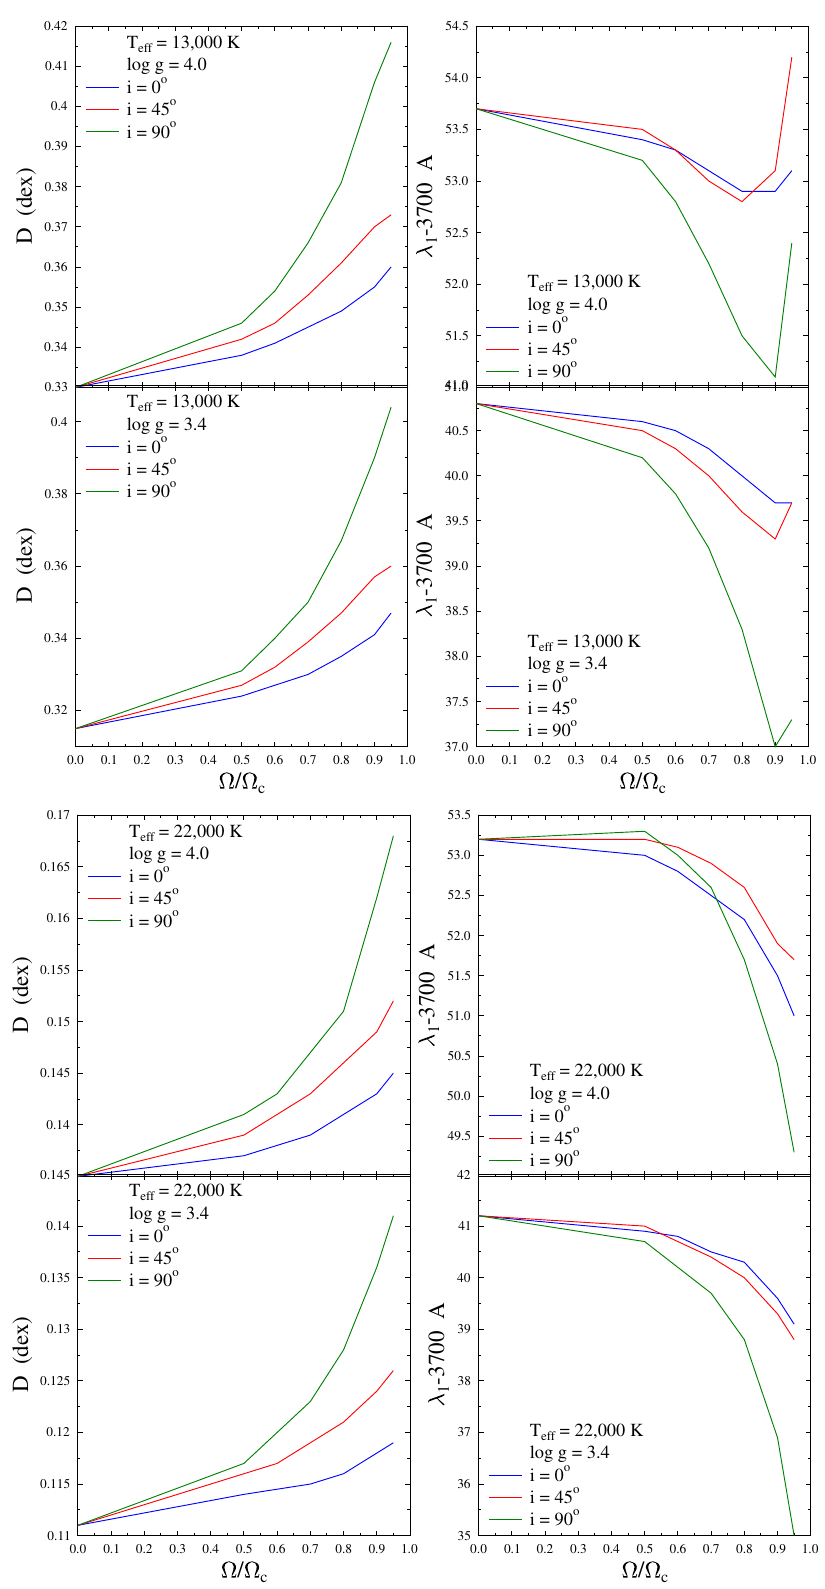
Figure 21. Apparent parameters ( λ 1 , D ) modified by the stellar rapid rotation in stars having the indi- cated pnrc fundamental parameters and for several inclination angles. Adapted from Zorec et al.